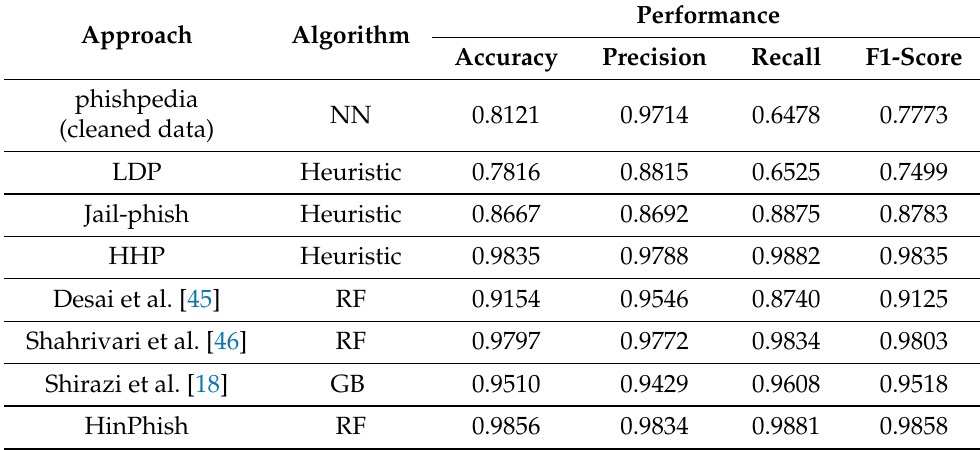
Table 6. Descriptions and performances of different approaches.